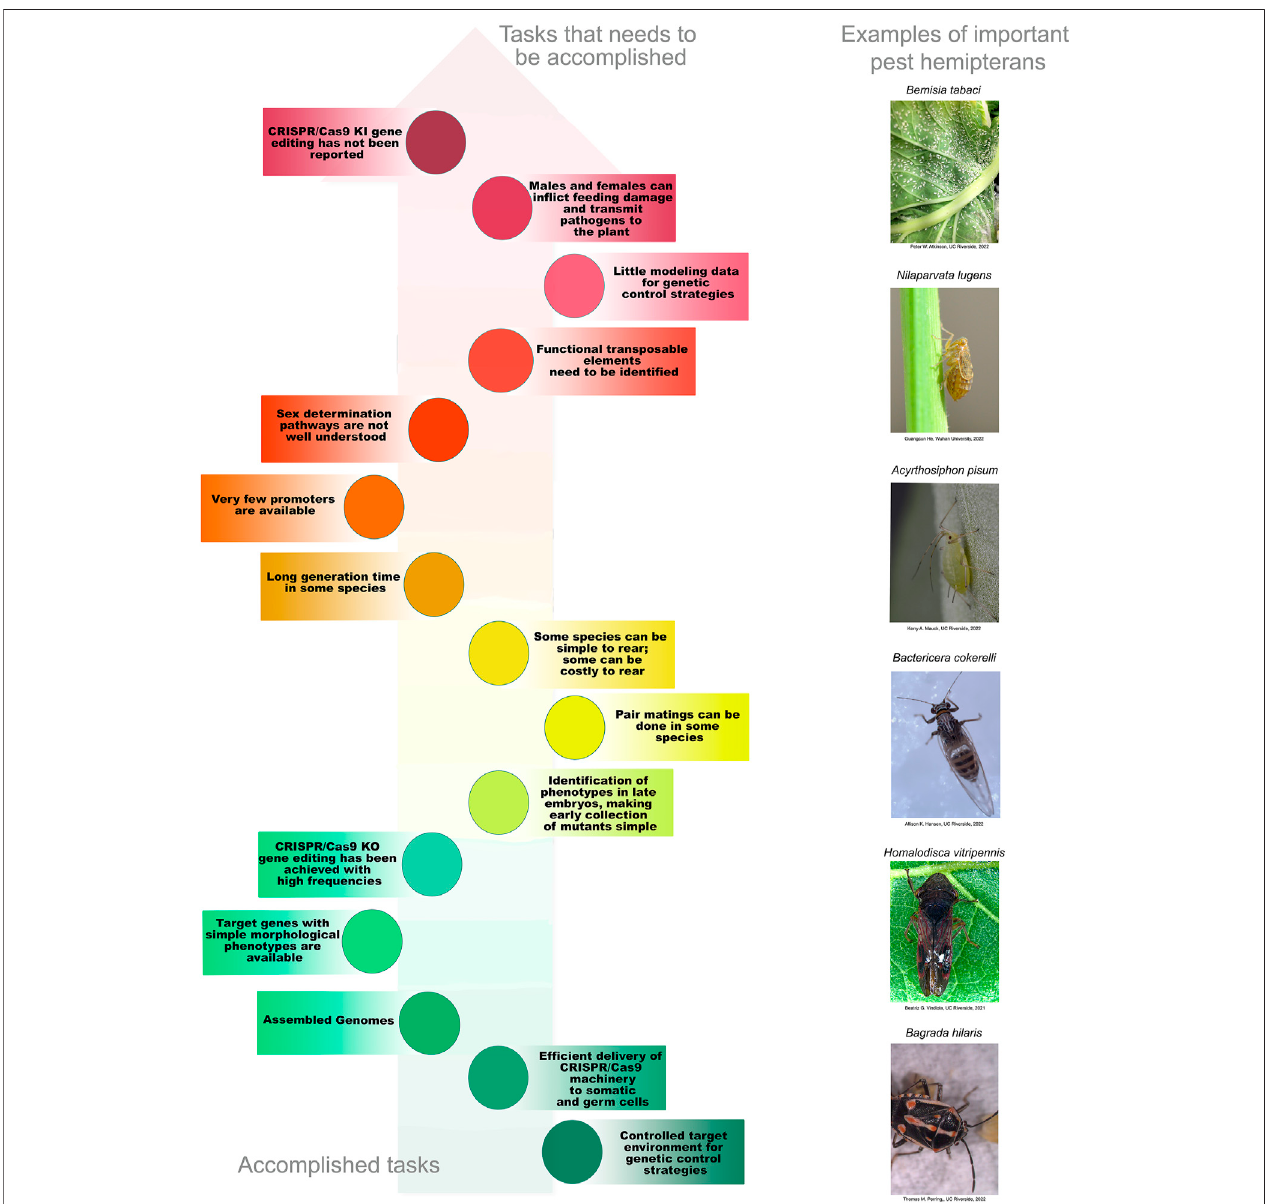
FIGURE 5 | The progress made in establishing genetic technologies in the Hemiptera with green circles and panels depicting tasks that have been accomplished, pale green to tan circles and panels depicting relevant biological traits among Hemiptera that may affect our ability to ef fi ciently extend genetic technologies to some species, and orange to dark red circles and panels depicting tasks that still need to be